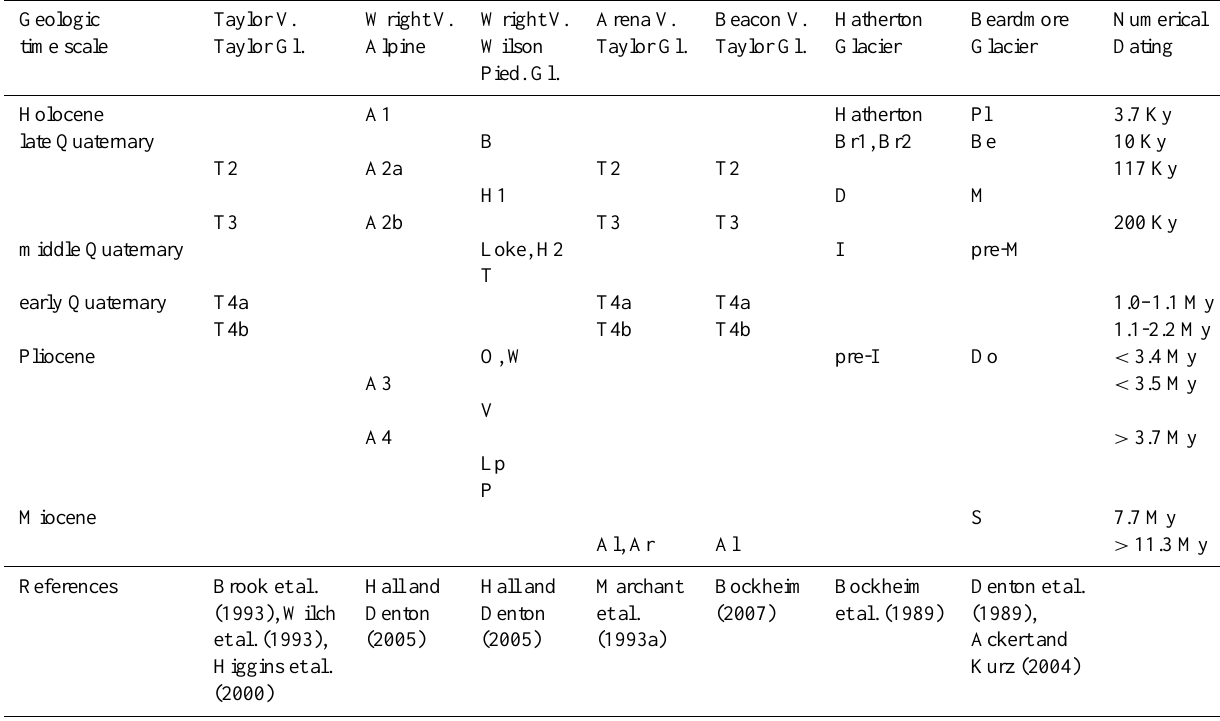
Table 2. Provisional correlation of glacial deposits ∗ in the Transantarctic Mountains.